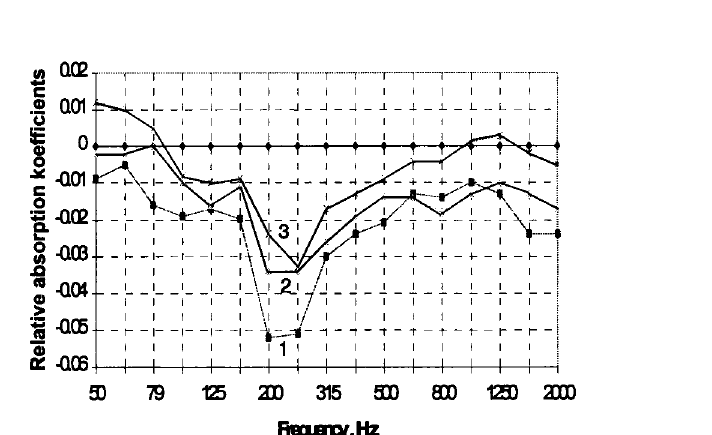
Fig. 6. The relative dependence of the sound absorption coefficients on the distance from the resonant suspended ceiling to the rigid ceiling surface. Slit width 100 em. The zero line corresponds to the case when no suspended ceiling is installed. 1 - distance to the rigid surface H = 100 em; 2 - 200 em; 3 - 400